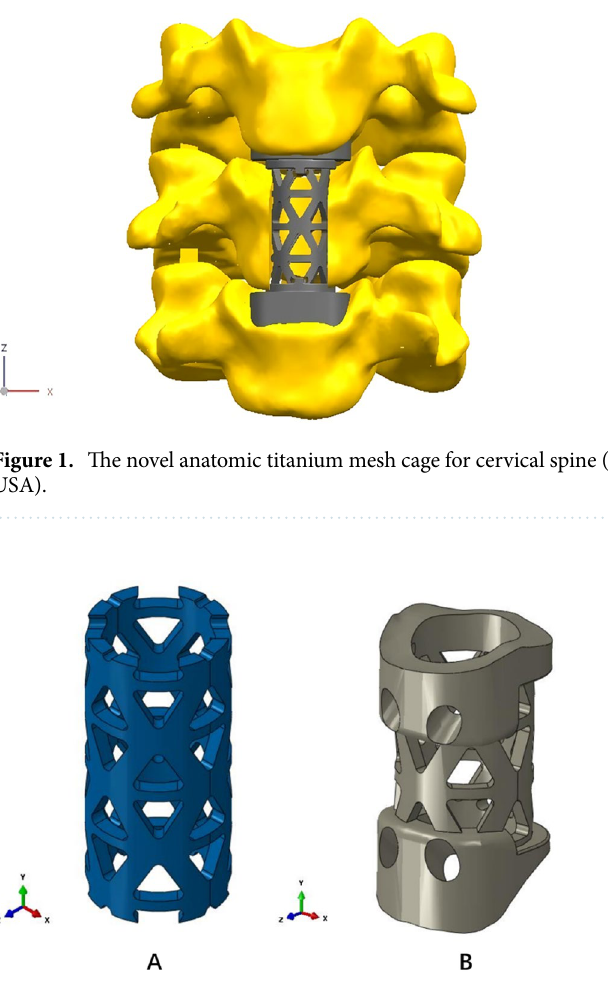
Figure 2. Two titanium mesh cage (TMC) models. ( A ) Traditional titanium mesh cage (TTMC); ( B ) novel titanium mesh cage (NTMC) (Solidworks 2016, SOLIDWORKS Co,